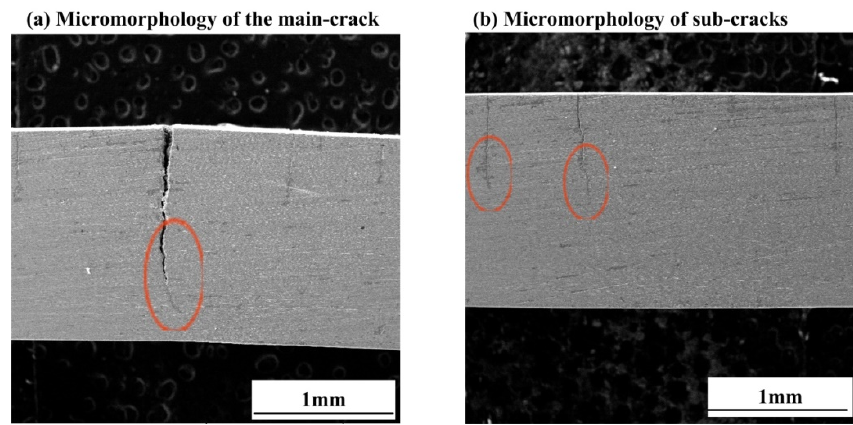
Figure 5. The side morphology of the fractured sample: ( a ) Main crack tip propagation morphology and ( b ) Growth morphology of sub ‐ cracks tip.